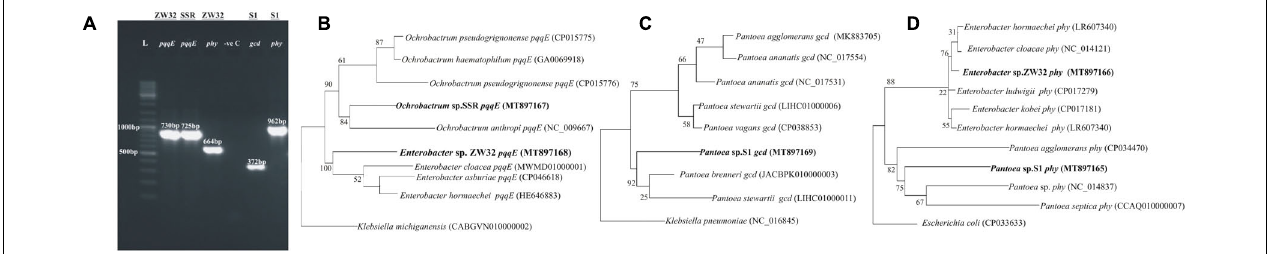
FIGURE 3 | Amplification and sequence-based phylogenetic trees of pqqE , glucose dehydrogenase ( gcd ), and phytase ( phy ) genes of Enterobacter sp. ZW32, Ochrobactrum sp. SSR, and Pantoea sp. S1. Gel photograph indicating amplification of pqqE , gcd , and phy genes (A) . Sequence-based phylogenetic trees of pqqE gene (B) , gcd gene (C) , and phy genes (D) were constructed by maximum likelihood method.